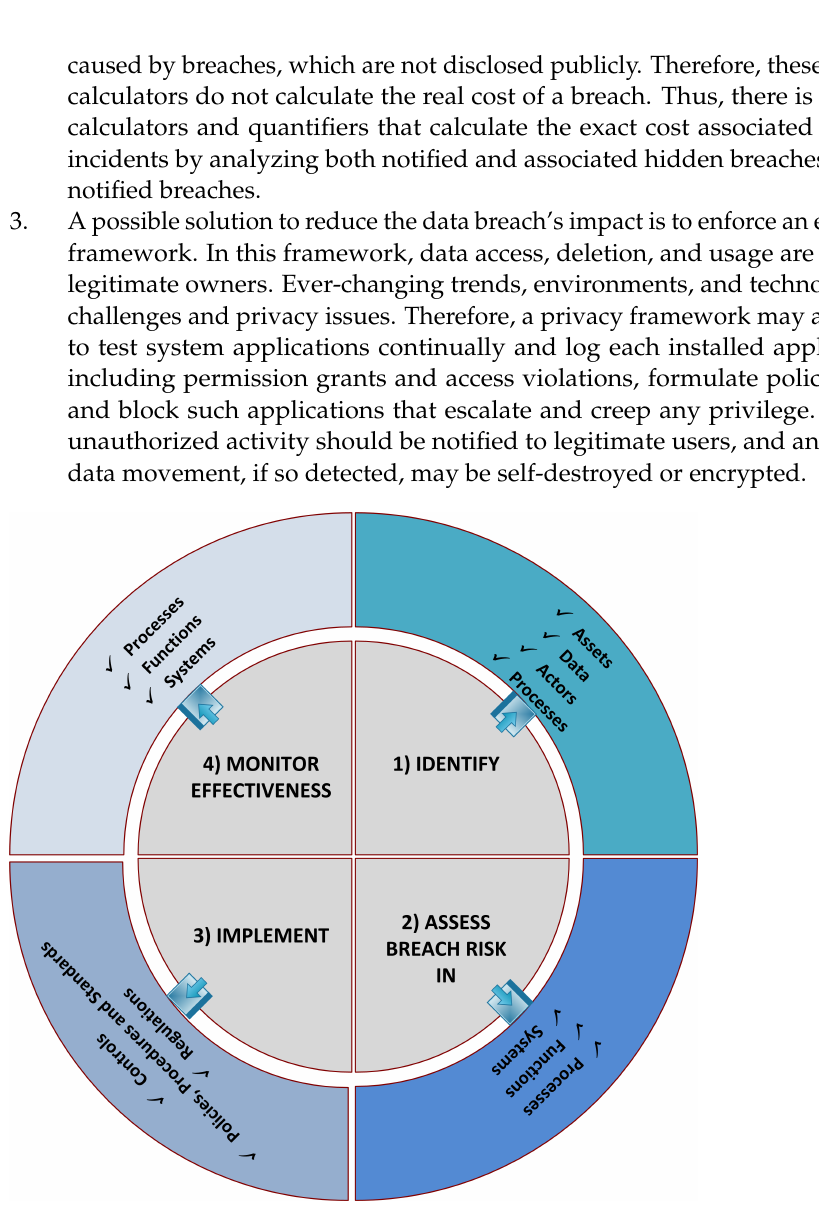
Figure 8. Continuous data breach risk assessment